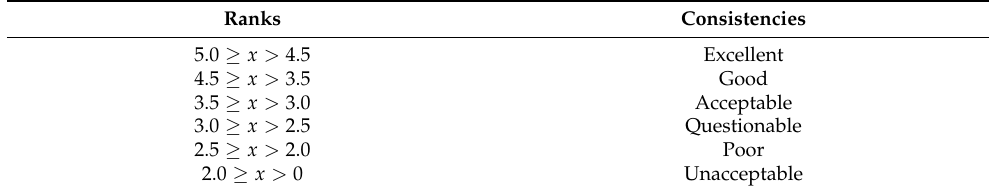
Table 6. VEU consistency